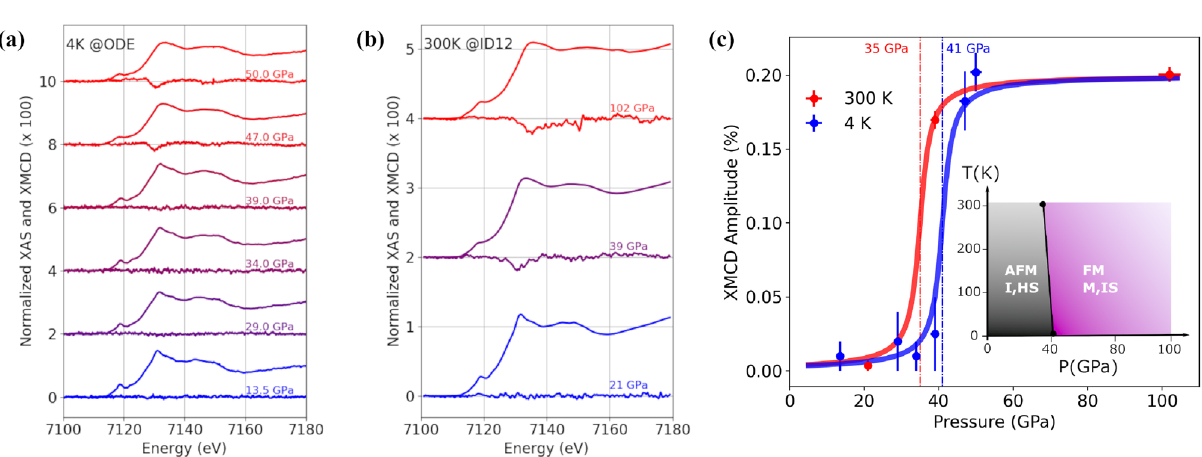
Figure 2. XAS and XMCD spectra for increasing pressure from bottom to top measured at 4 K ( a ) and 300 K ( b ); ( c ): XMCD amplitude at 4 K (blue circles) and 300 K (red circles); thick lines are guides to the eyes and dashed lines mark the AFM—FM pressure transition P m ; the inset shows a schematic phase diagram of the AFM and FM